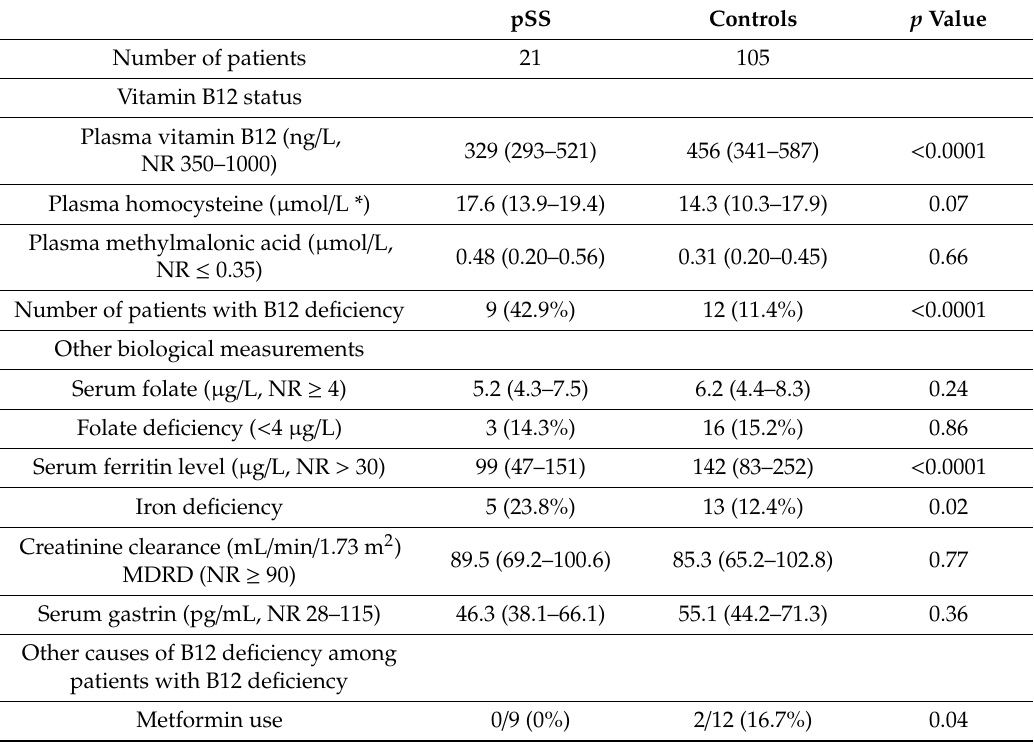
Figure 1. Distribution of vitamin B12 levels in pSS patients and controls. Notes: Plasma vitamin B12 is presented with median and quartiles. Table 2. Comparison of nutrient characteristics in the two groups.